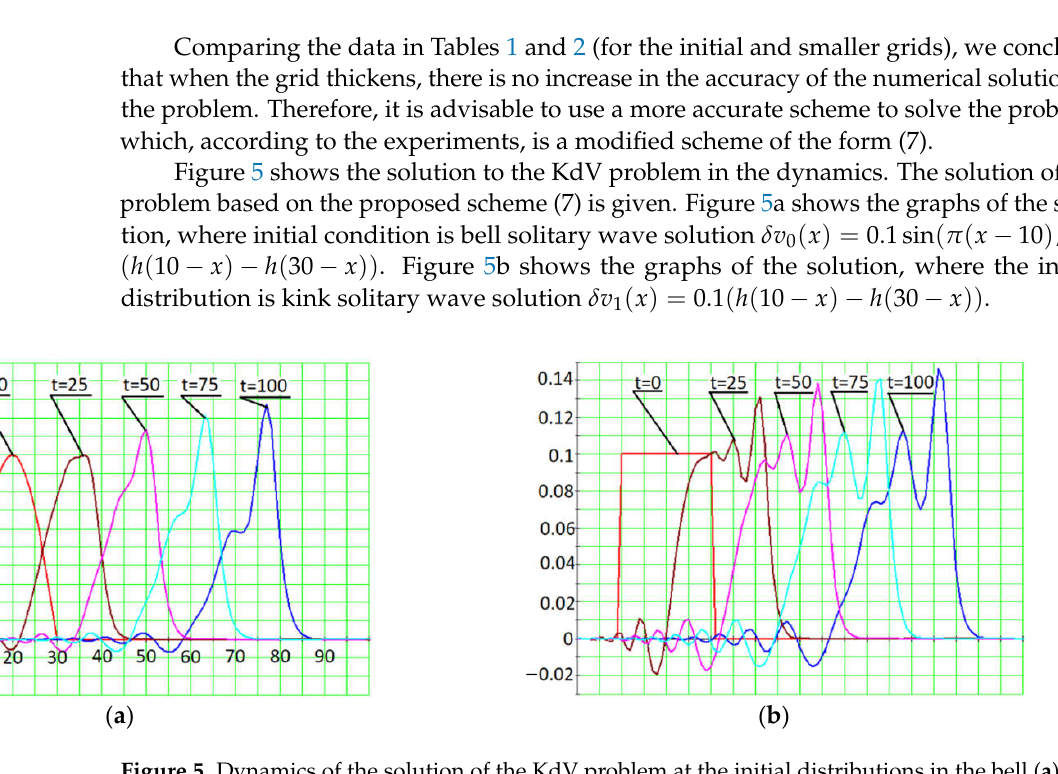
Figure 4. Numerical solution of the test nonlinear KdV problem based on the schemes: “left corner” ( a ), the “Standard Leapfrog” ( b ), the “Upwind Leapfrog” ( c ), the scheme (7) ( d ).